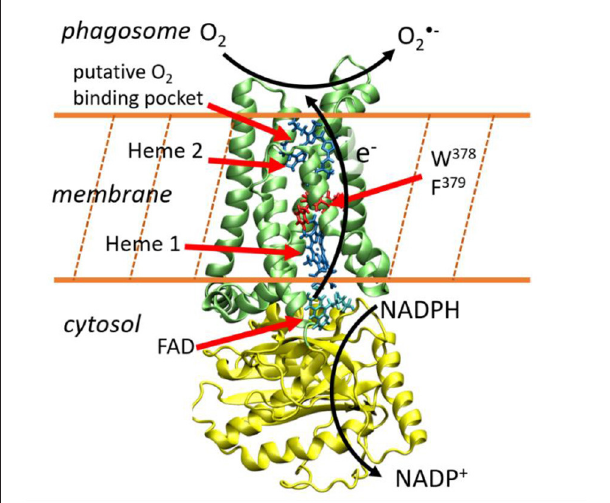
FIGURE 1 | Electron transfer across the membrane catalyzes the production of superoxide anions. This image has been generated using the NOX5 model reported in Magnani et al. (2017). The yellow and green protein domains are the dehydrogenase and transmembrane domains respectively.